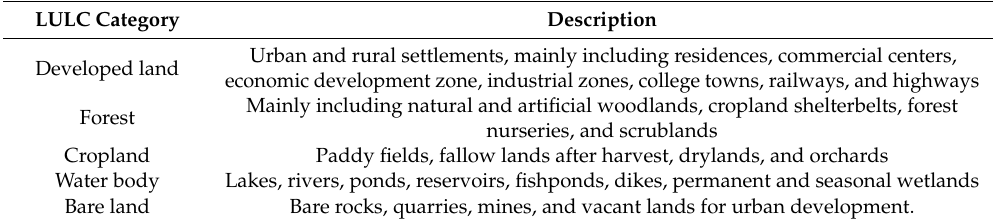
Table 1. Land use / land cover (LULC) categories adopted in this study.